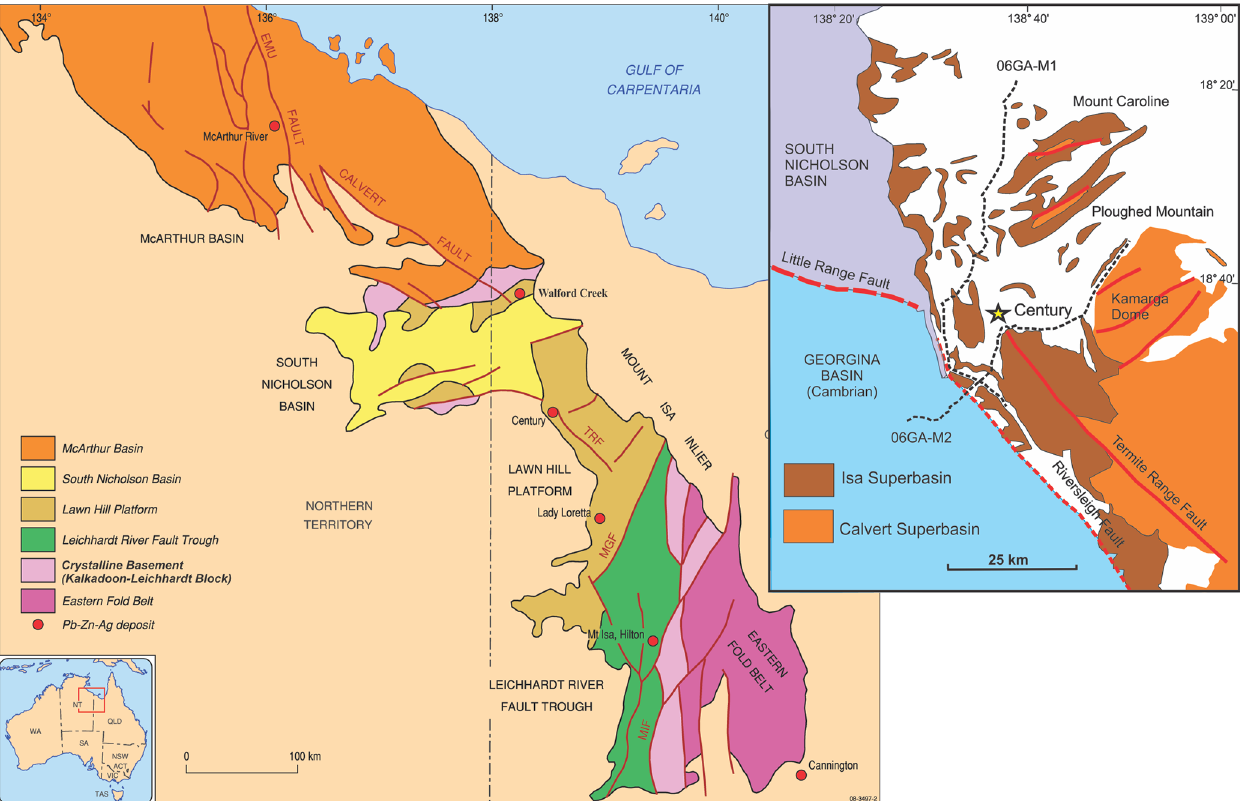
Figure 1. (a) Simplified geological map for northern Australia showing principal tectono-morphological elements and Pb–Zn mineral deposits (after Jackson et al., 2000). (b) More detailed geological map of periclinal folds developed in stratigraphy of the inverted Isa Superbasin on the Lawn Hill Platform northeast of Century Mine and seismic reflection lines 06GAM1 and 06GAM2 along which these structures are imaged. Figure reproduced with permission under the Creative Commons Attribution 4.0 International License: http://creativecommons.org/licenses/by/4.0/legalcode (last access: 2 July 2020). © Commonwealth of Australia (Geoscience Australia)